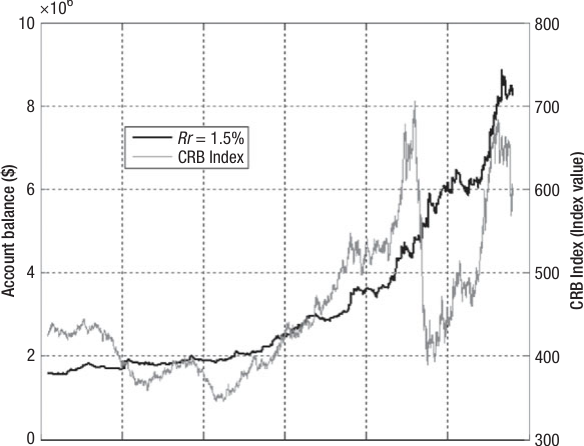
Fig. 5. Account balance and CRB index